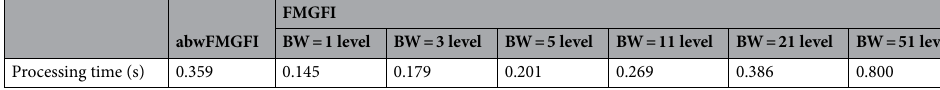
Table 17. Processing time of each filter.